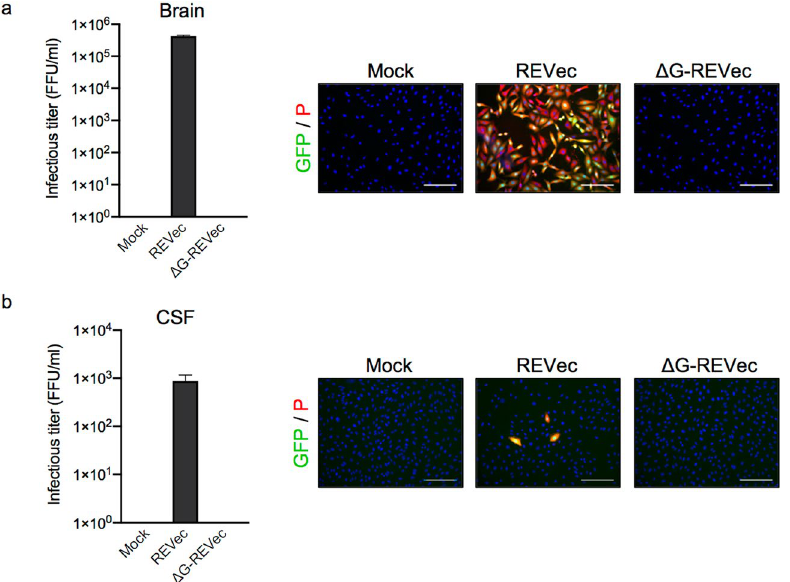
Figure 5. Quantification of infectious vector titer in brain and CSF. ( a ) Infectious vector titer in brain was quantified by focus-forming assay by inoculating Vero cells with serial dilutions of brain homogenates (n = 3). ( b ) Infectious titer of REVec in CSF was determined as above (n = 3). Representative images of Vero cells inoculated with brain homogenates or CSF and immunostained with BoDV-P antibody is shown to the right. Scale bar, 100 μ